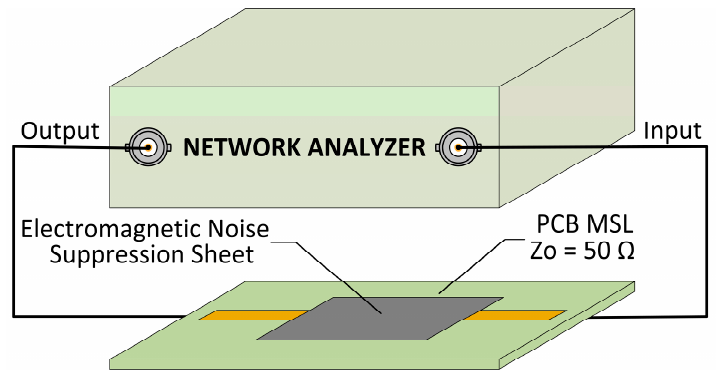
Figure 3. Measurement of reflection and transmission loss through microstrip line (MSL) test fixture.